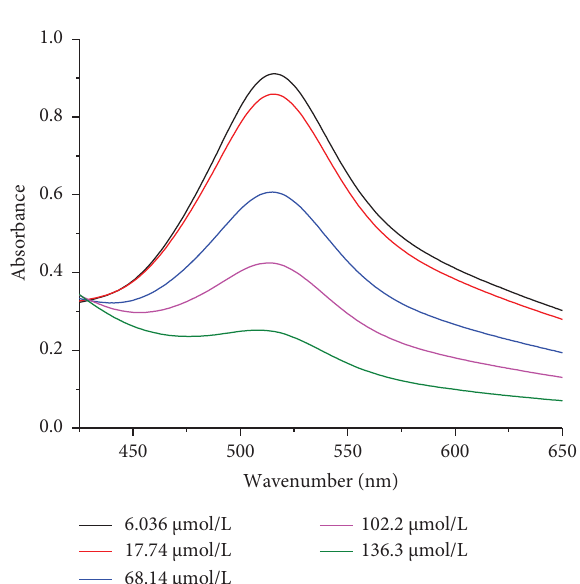
Figure 2: Overlay spectra of ascorbic acid standard DPPH scav- enging activities.